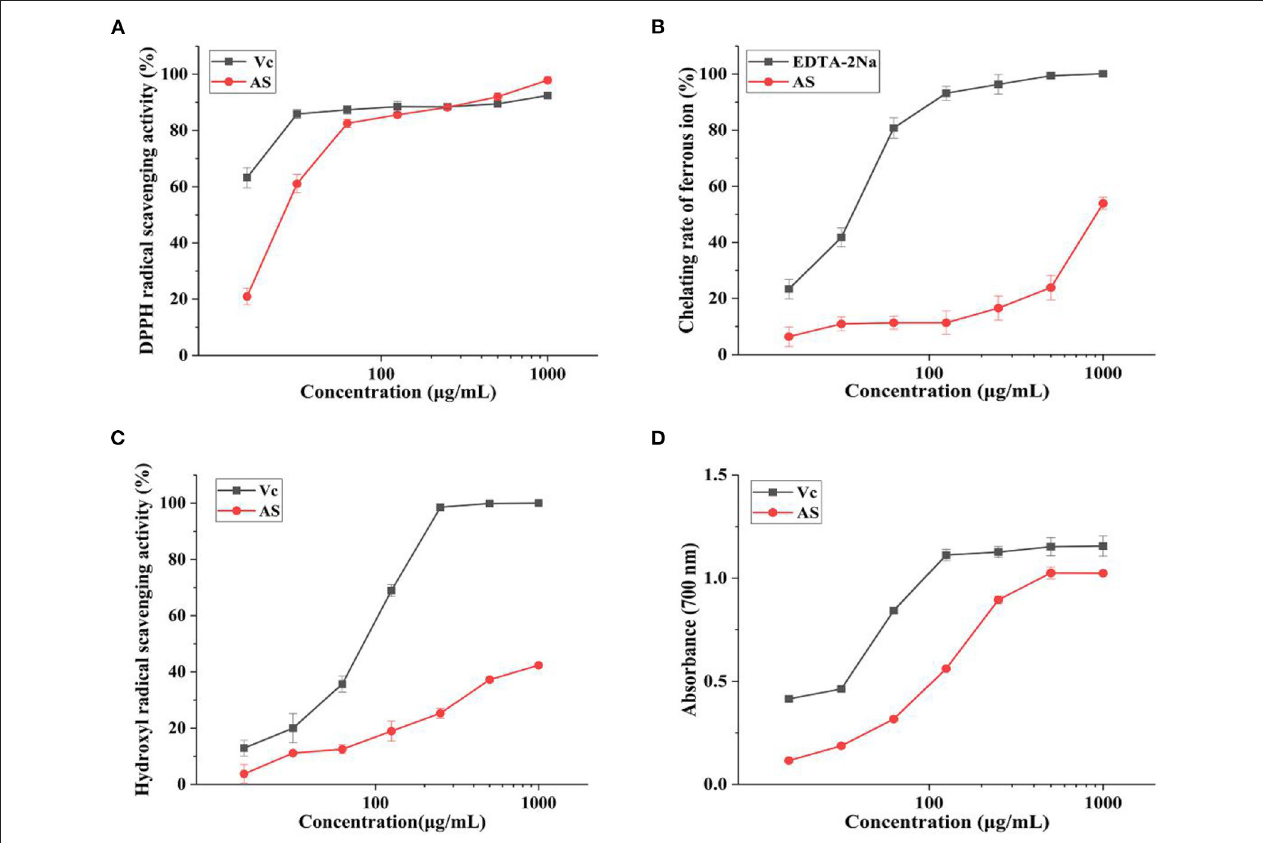
FIGURE 1 | Antioxidant activities of AS at different concentrations (A) DPPH radical scavenging activity of AS and VC. (B) Ferrous ion-chelating rate of AS and EDTA-2Na. (C) Hydroxyl radical scavenging activity of AS and VC. (D) Reducing power of AS and VC. Data are shown as the mean ± SD ( n = 3) ( Supplementary Table 4